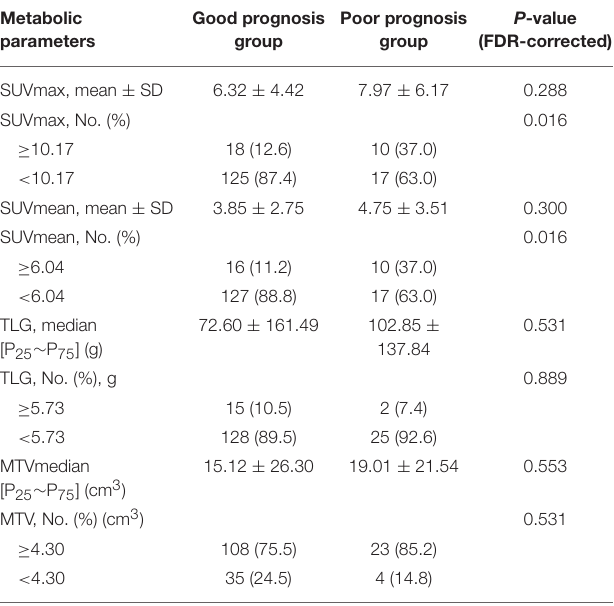
TABLE 2 | The comparison of metabolic parameters between good prognosis group and poor prognosis group. Metabolic parameters